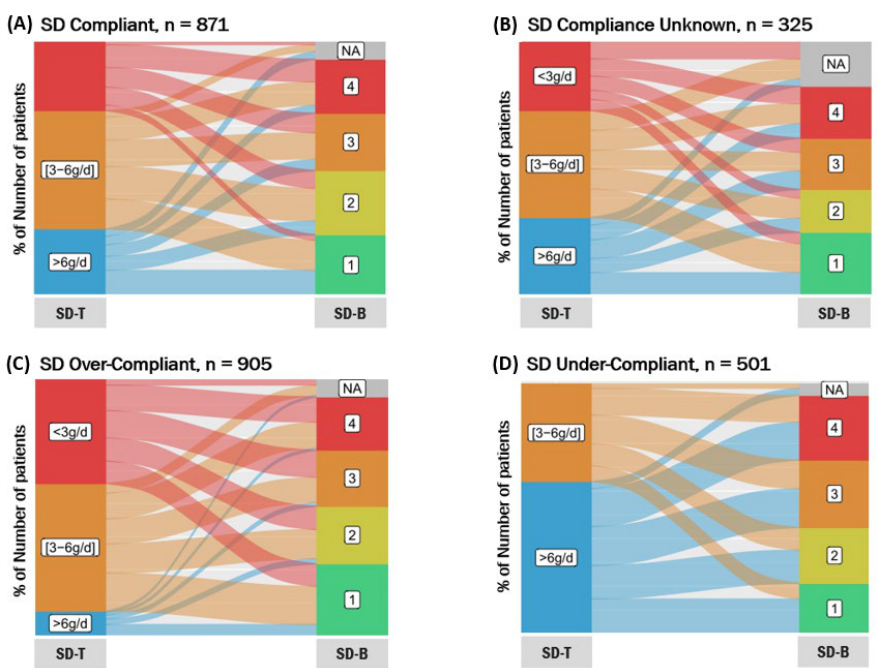
Figure 3. Sankey plots showing the correlation between daily salt diet taken (SD-T) and salt diet burden (SD-B) estimated using the BIRD questionnaire score depending on the compliance of the patients: ( A ) compliant; ( B ) compliance unknown; ( C ) overcompliant; ( D ) undercompliant.